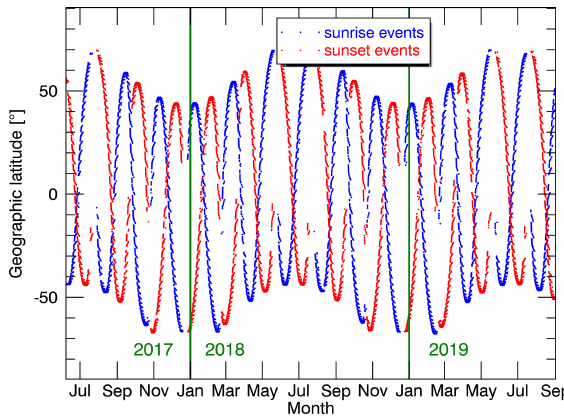
Figure 1. Latitudinal coverage of SAGE III/ISS solar occultation measurements between June 2017 and September 2019. Observed sunrise and sunset events are shown in blue and red, respectively. Green vertical lines mark turns of the year. Table 1. Spectral channels of the SAGE III/ISS level 2 solar aerosol product and the respective extinction measurement uncertainties, as provided by the NASA Atmospheric Science Data Center (NASA, 2020), averaged from June 2017 to December 2019 at 20km alti- tude. λ